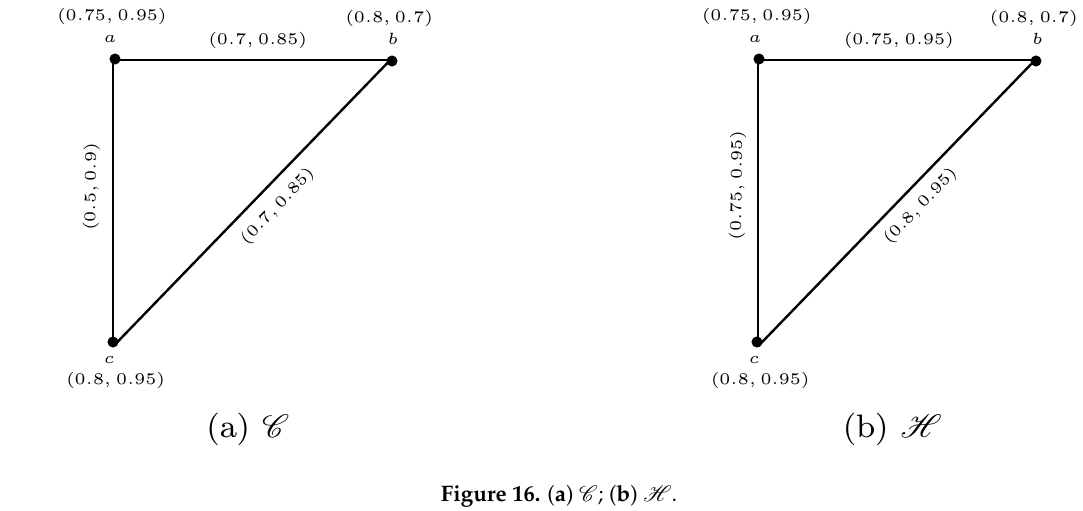
Figure 4.7( b ) represents a complete q -ROFG H = ( P , R ) induced by P . Clearly, H is not a subgraph of